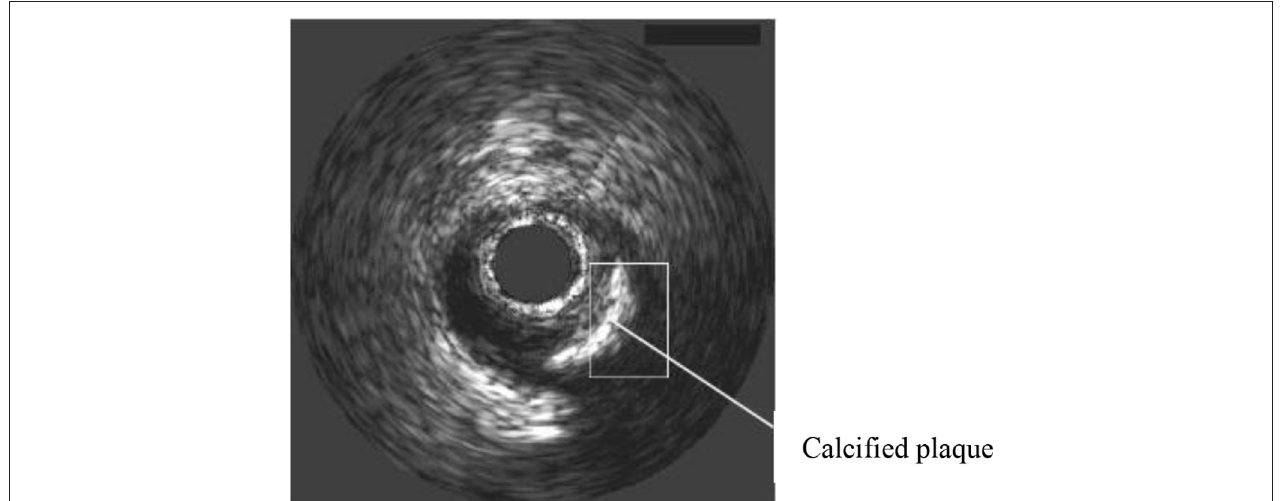
FIGURE 6 | Ultrasound vascular acoustic